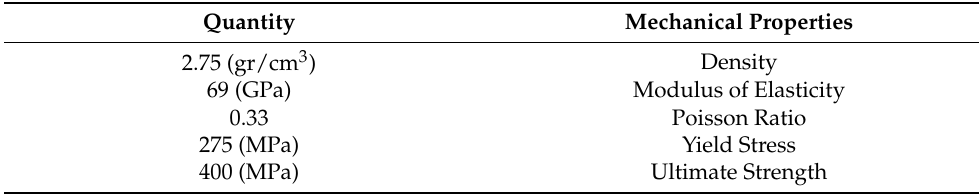
Table 1. Mechanical properties of aluminum alloy 6061.